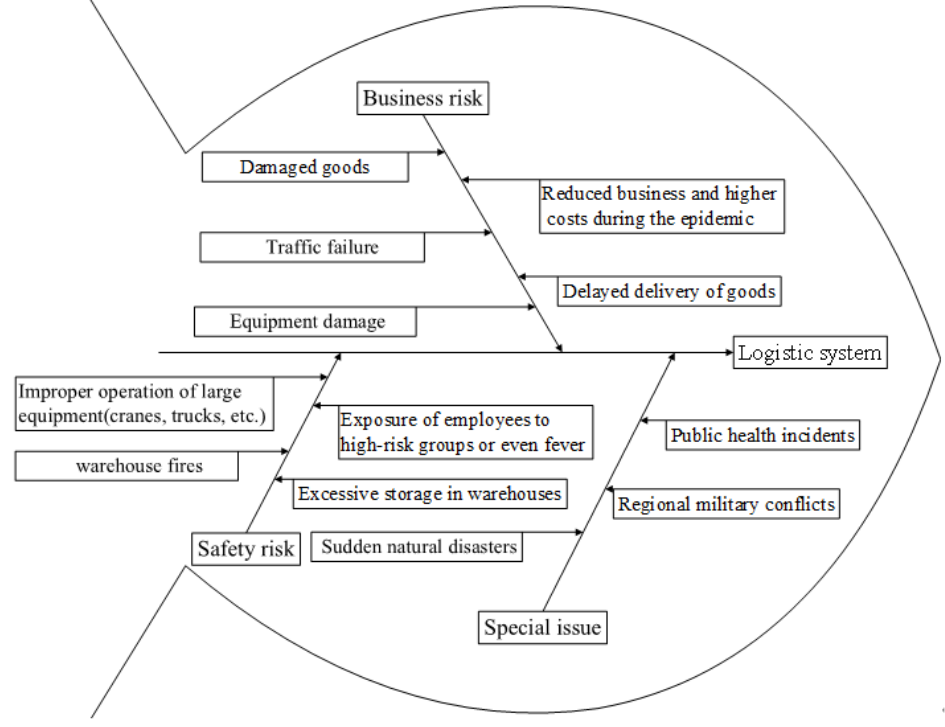
Figure 2. Logistic System Classification.